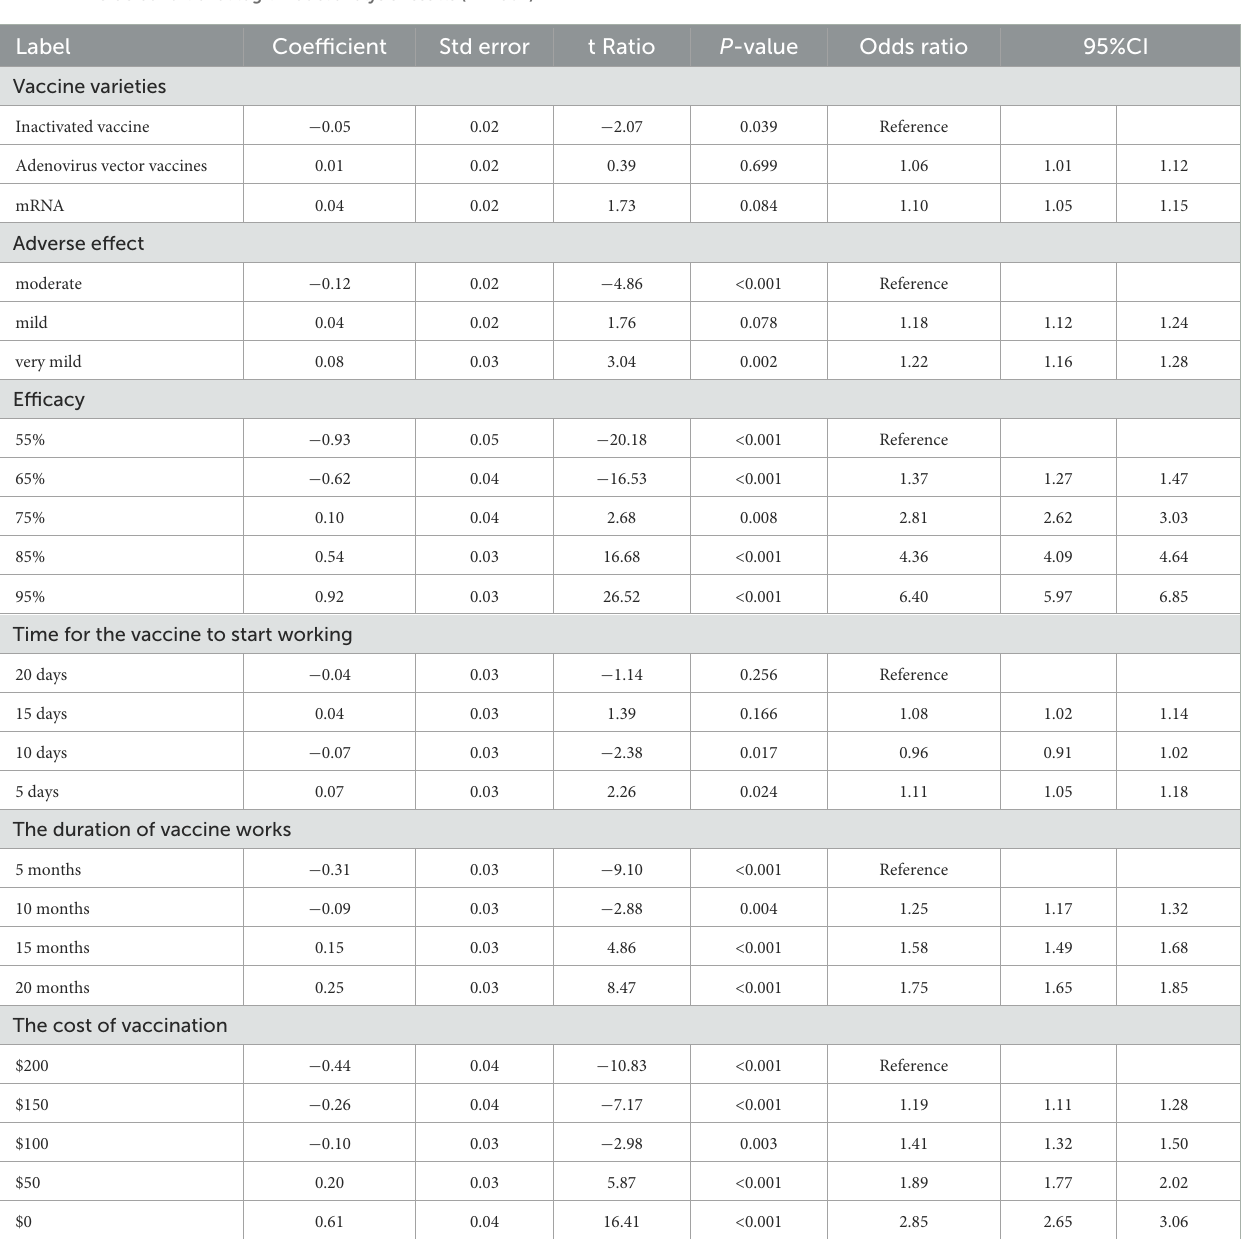
TABLE 4 The US conditional logit model analysis results ( n =